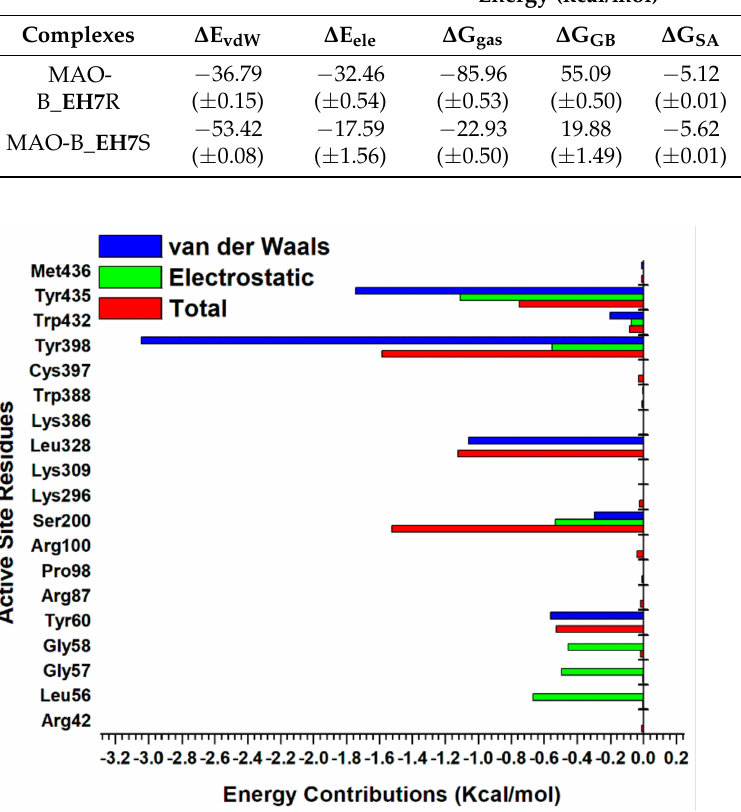
Figure 10. Per residue decomposition of MAO-B_ EH7 S enantiomer.